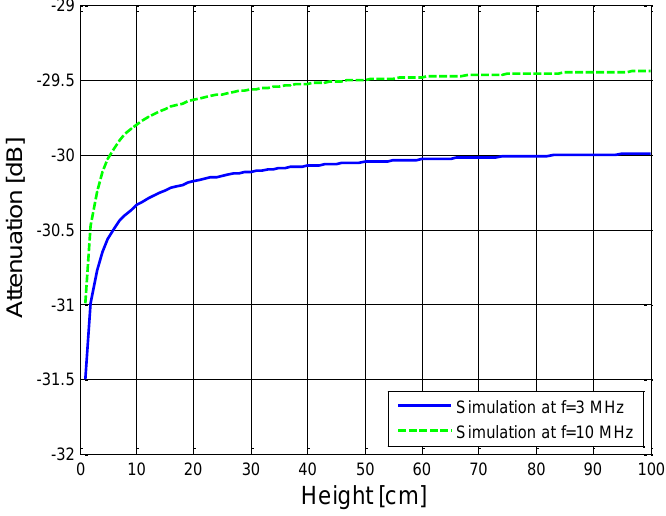
Figure 12. Simulation results corresponding to the different heights between the arm and the external